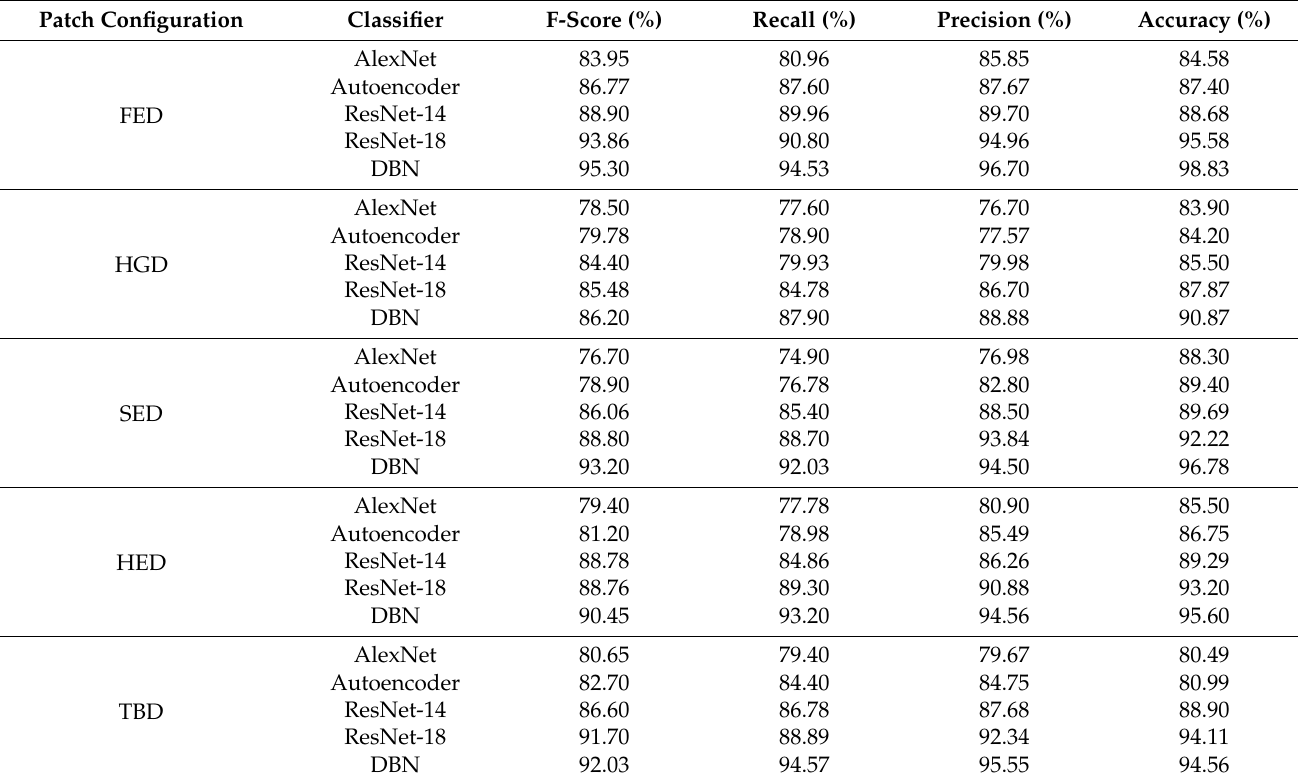
Table 3. Experimental results of various classification techniques with